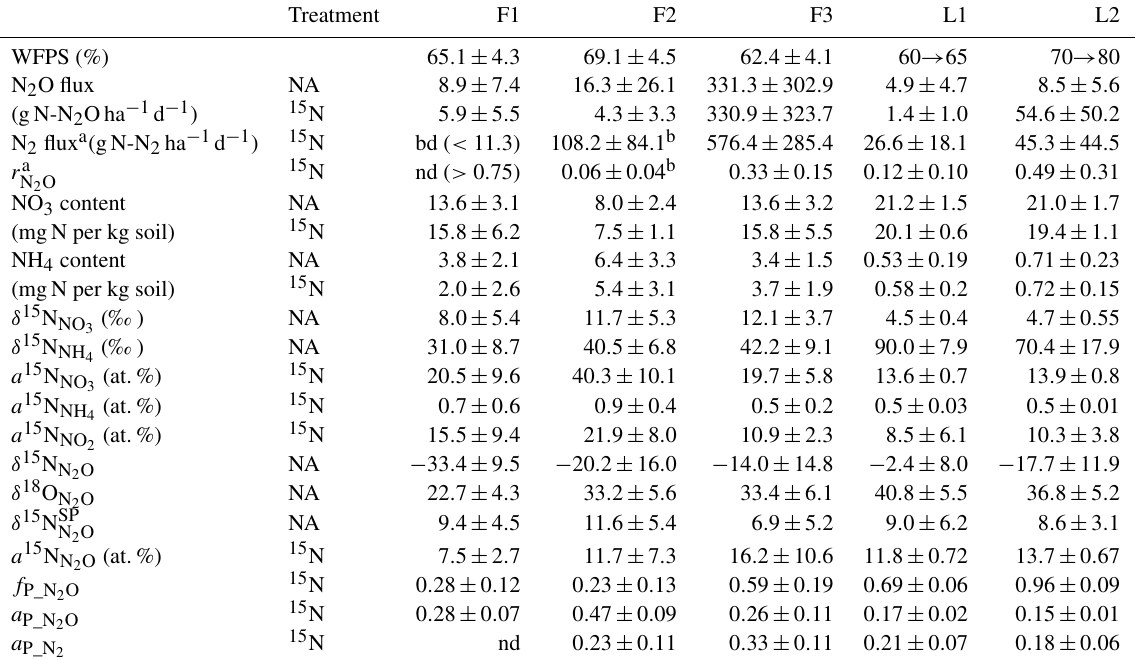
Table 2. Results summary.